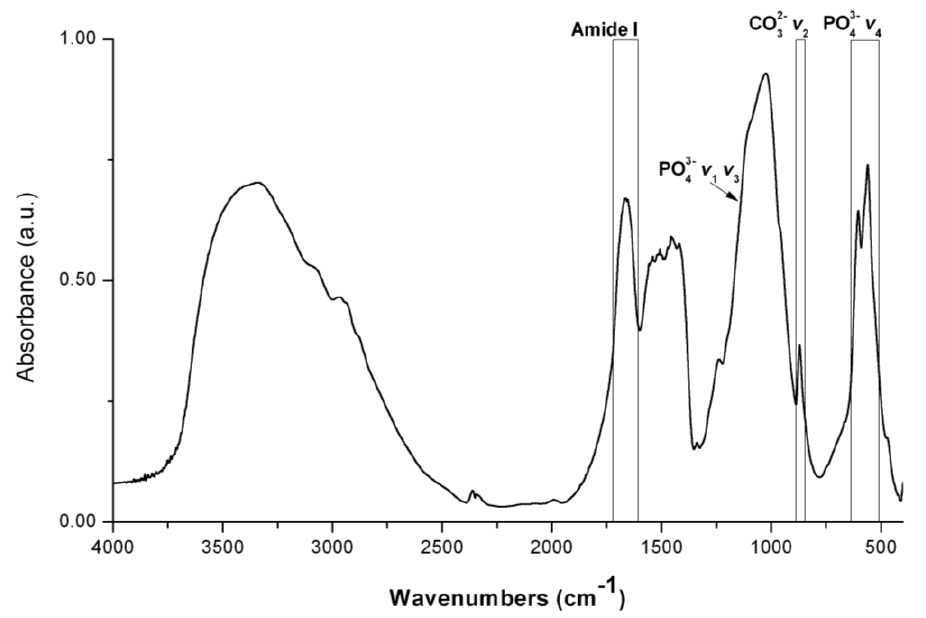
FIGURE 1. Typical IR spectra of homogenized bone samples. Regions of interest are